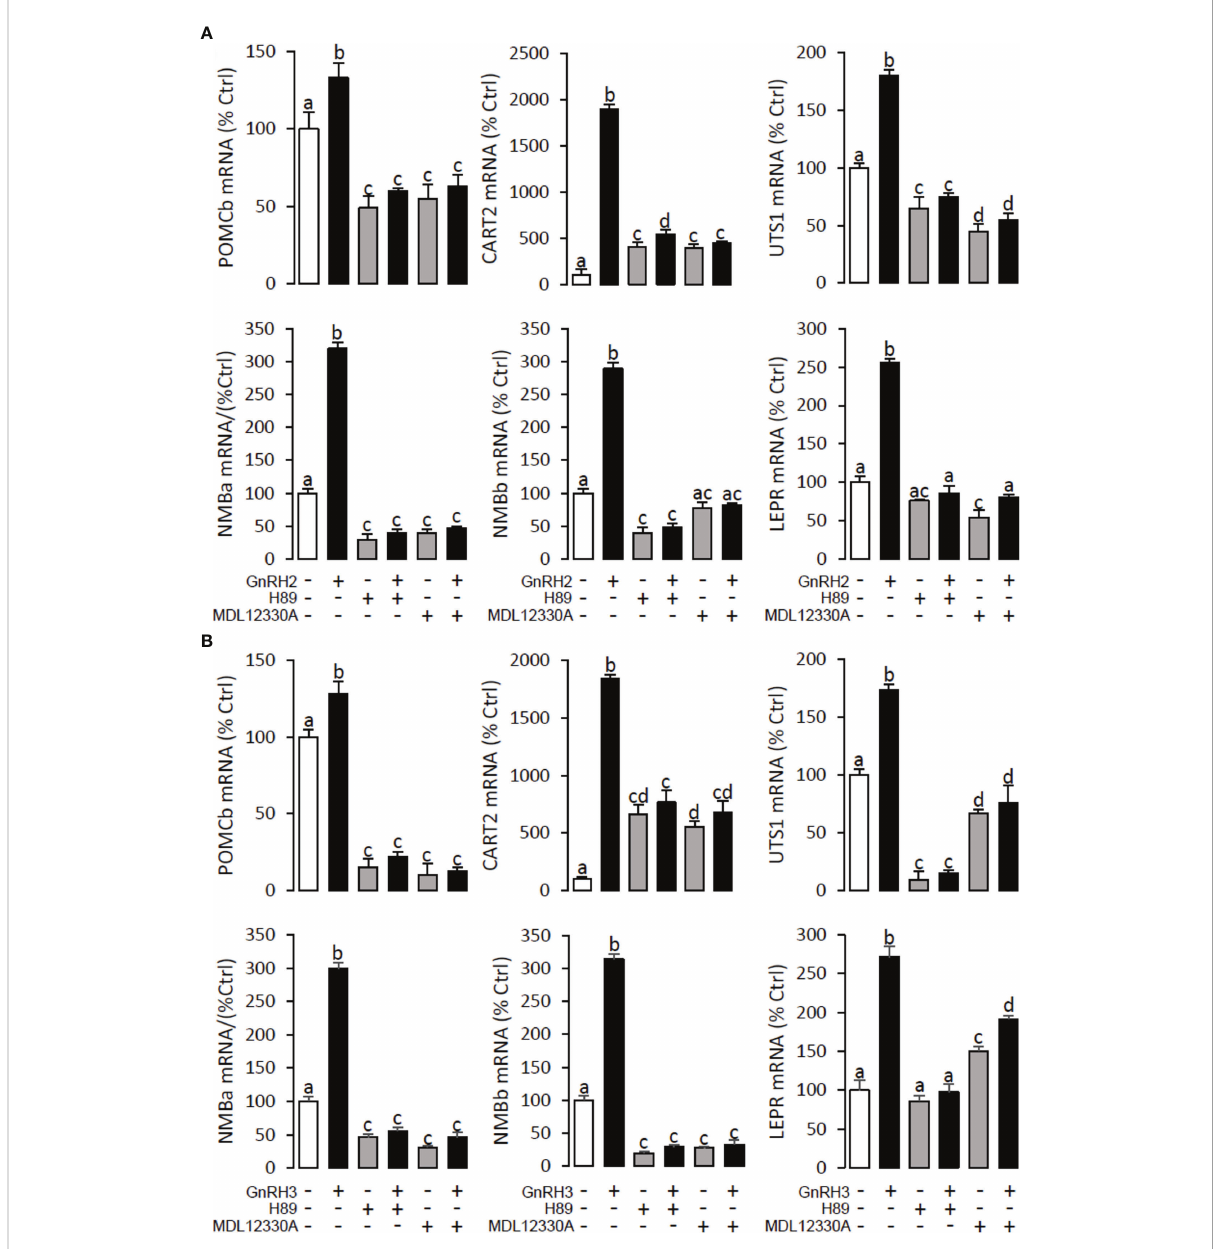
FIGURE 11 Signal transduction for GnRH2- and GnRH3-induced POMCb, CART2, UTS1, NMBa, NMBb, and LEPR mRNA expression in grass carp pituitary cells. In this experiment, GnRH2 (A) or GnRH3 (B) combined with / without the AC inhibitor MDL12330A (20 m M) or PKA inhibitor H89 (20 m M) was used to incubate the grass carp pituitary cells for 24 (h) After drug treatment, the total RNA was extracted from the cells for real-time PCR of the respective genes. Data presented are expressed as mean ± SEM, and the different letters represent a signi fi cant difference at p < 0.05 between groups (ANOVA followed by a Dunnett